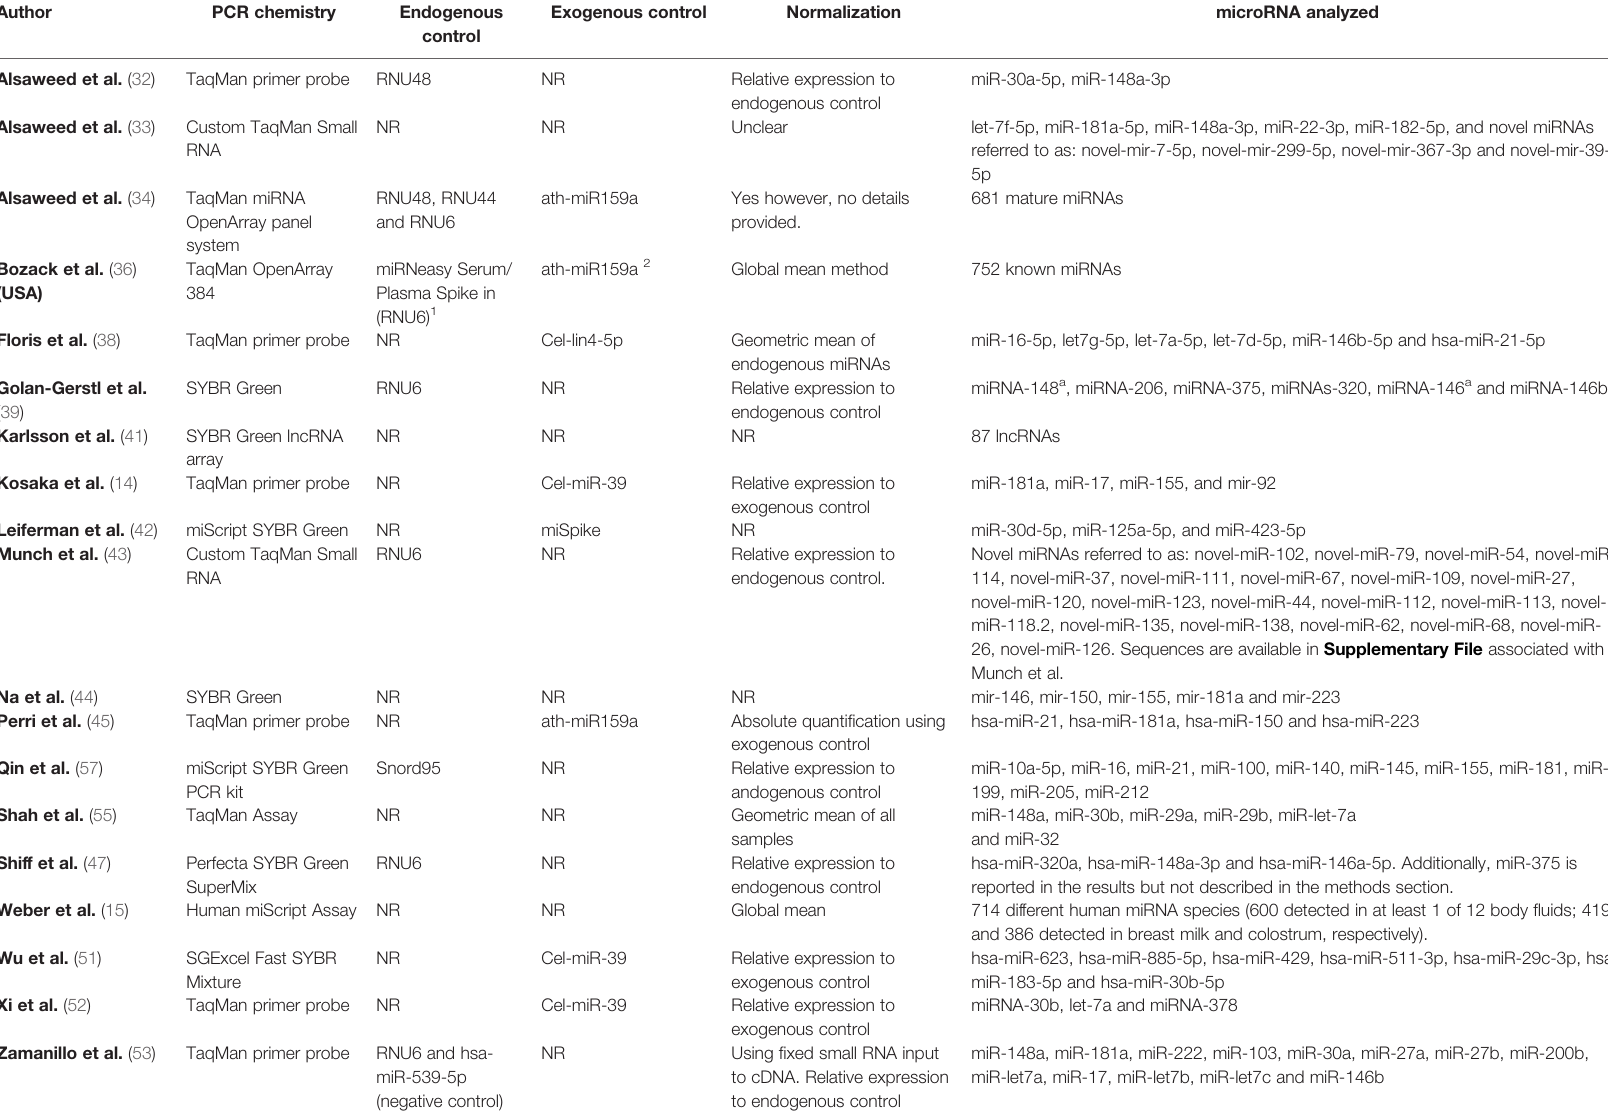
TABLE 2 | Methods of quanti fi cation in studies using qPCR and miRNA investigated.